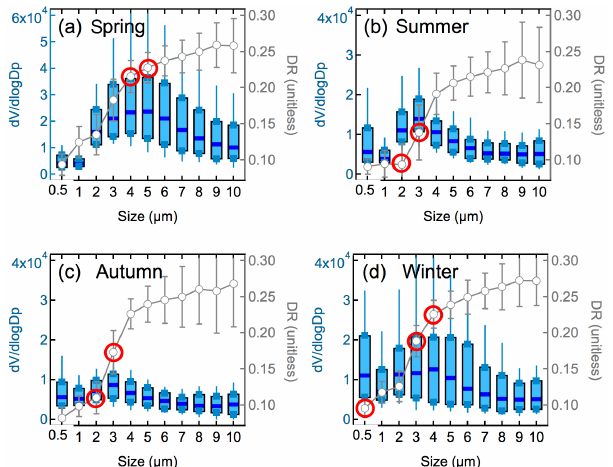
Figure 4. Volume size distribution (left axis) and size-dependent depolarization ratio (right axis) of aerosols in (a) spring (March, April, May: MAM), (b) summer (June, July, August: JJA), (c) au- tumn (September, October, November: SON), and (d) winter (De- cember, January, February: DJF). The box and whiskers in the plot represent the 10th, 25th, 75th, 90th percentiles and median values, and the red circles represent the corresponding DR values for the peak size range in the volume size